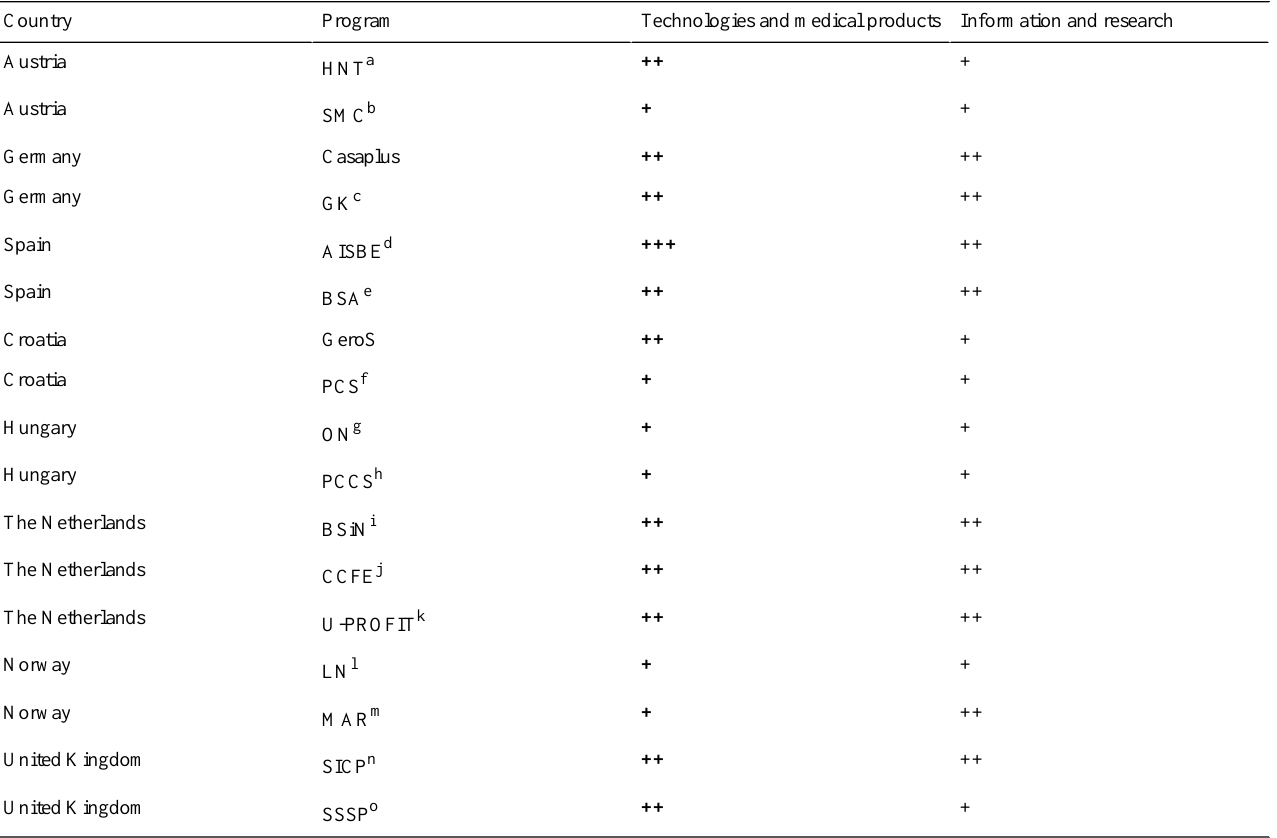
Table 2. Average maturity levels of the 17 Integrated Chronic Care programs.